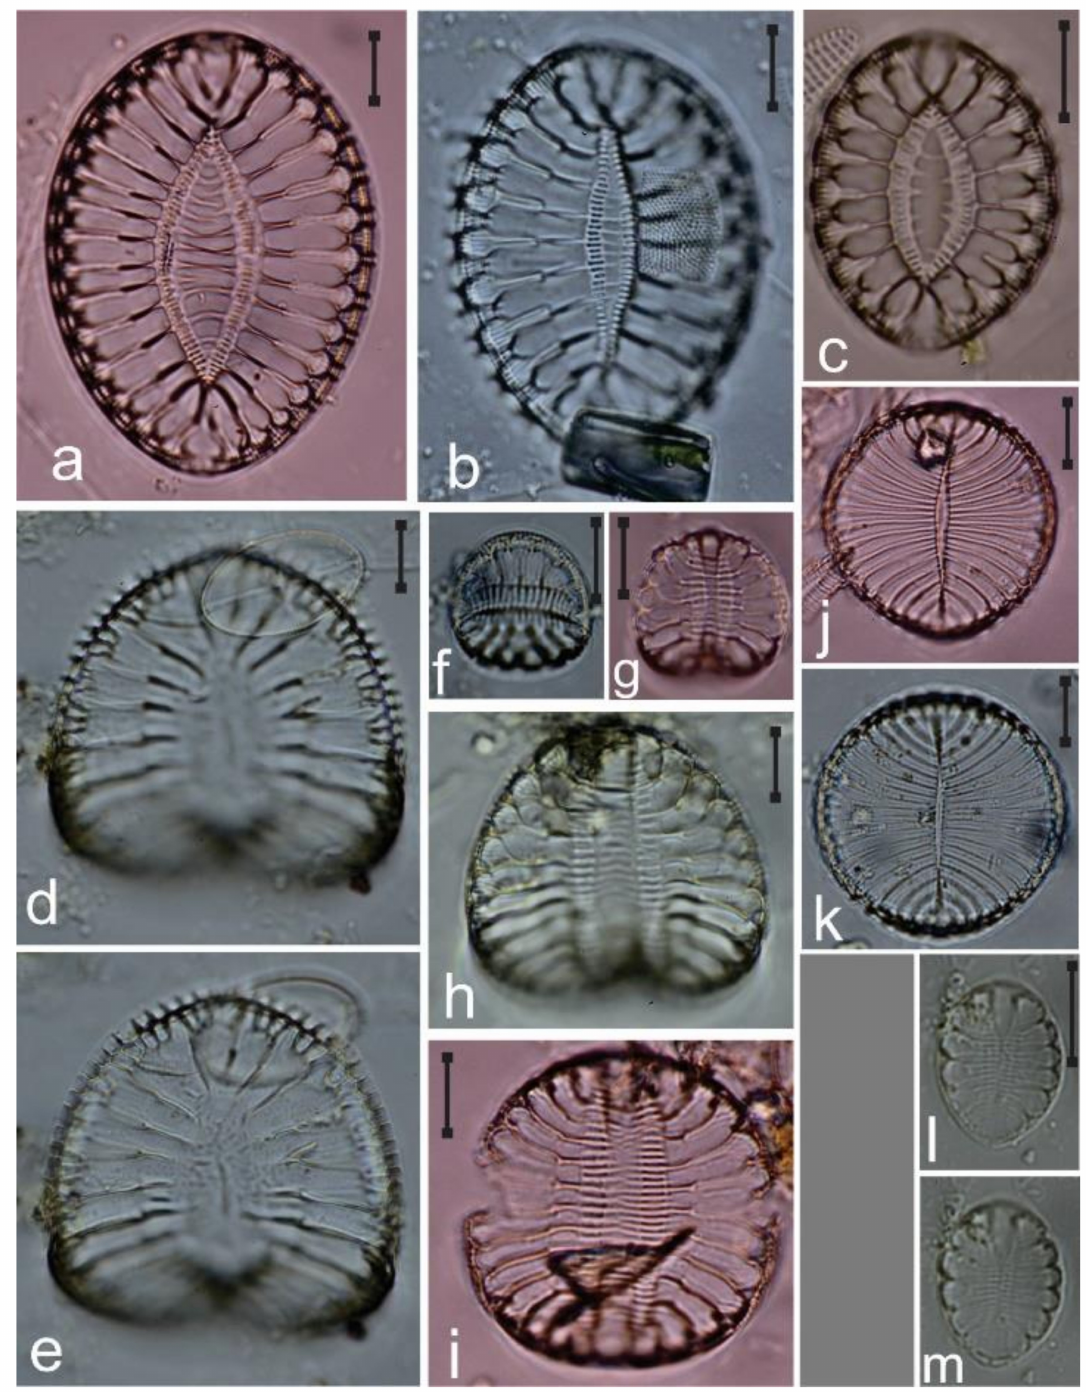
Figure 46. ( a – c ) Campylodiscus neofastuosus ; ( d , e ) Coronia ambigua two focal planes; ( f ) Campylodiscus bicostatus ; ( g ) C. simulans ; ( h , i ) C. fastuosus ; ( j , k ) C. ralfsii ; ( l , m ) C. scalaris . Scale bar = 10 µ